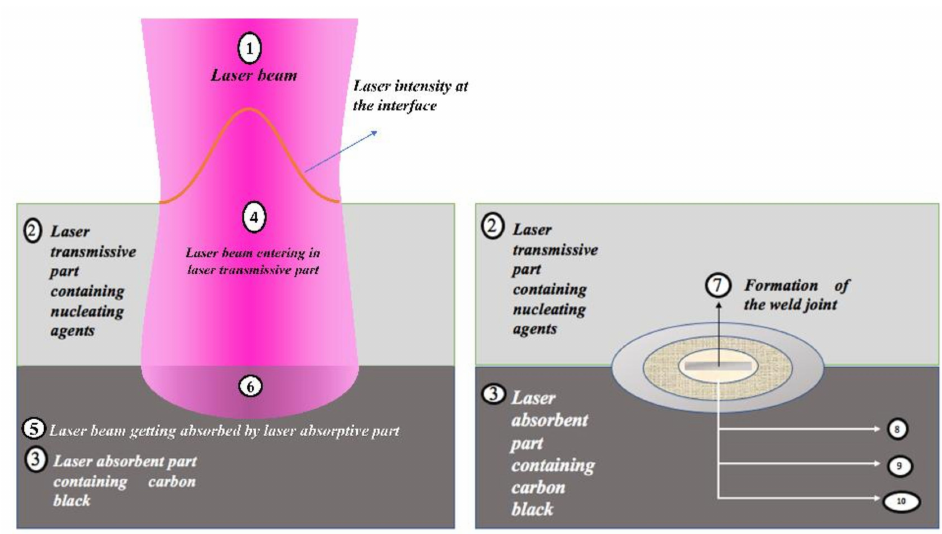
Figure 4. Lap joint and interaction of the laser beam during the LTW